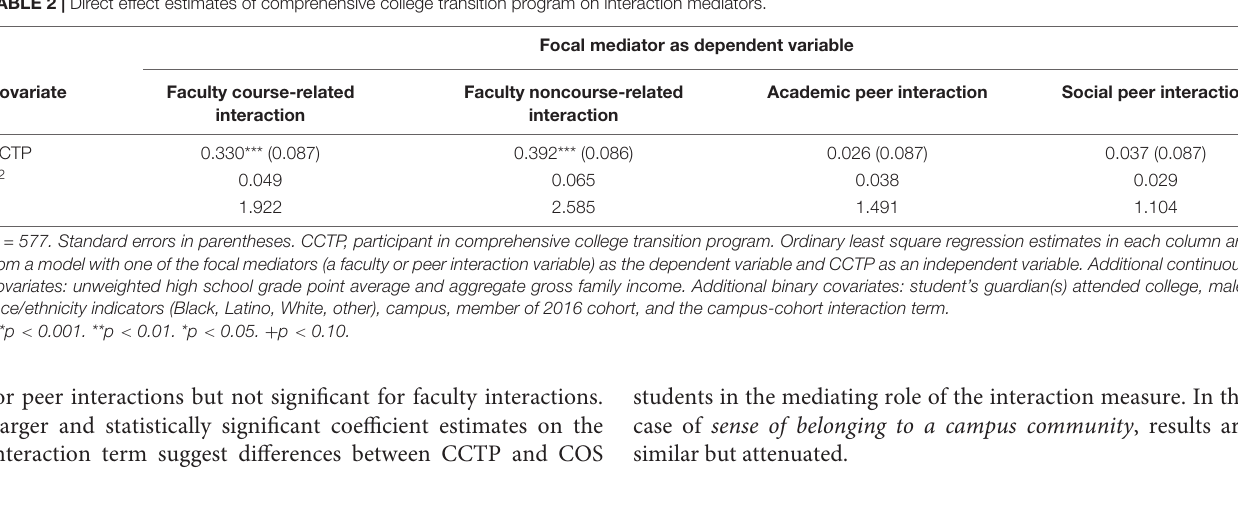
FIGURE 3 | R code for fitting causal mediation models academic peer interaction as the focal mediator and mattering to campus as the outcome. The package mediation is installed first. The mediator object med and the outcome object out are specified first via lm() , since the mediator T1APIR and outcome T2MATC are both continuous. With the mediate() function, the first two arguments indicate the two fitted model objects. Its last three arguments boot = TRUE , boot.ci.type = "bca" , and sims = 5000 indicate that the nonparametric bootstrap estimation approach is used for computing the bias-corrected and accelerated confidence intervals and the number of Monte Carlo draws for nonparametric bootstrap is 5000. TABLE 2 | Direct effect estimates of comprehensive college transition program on interaction